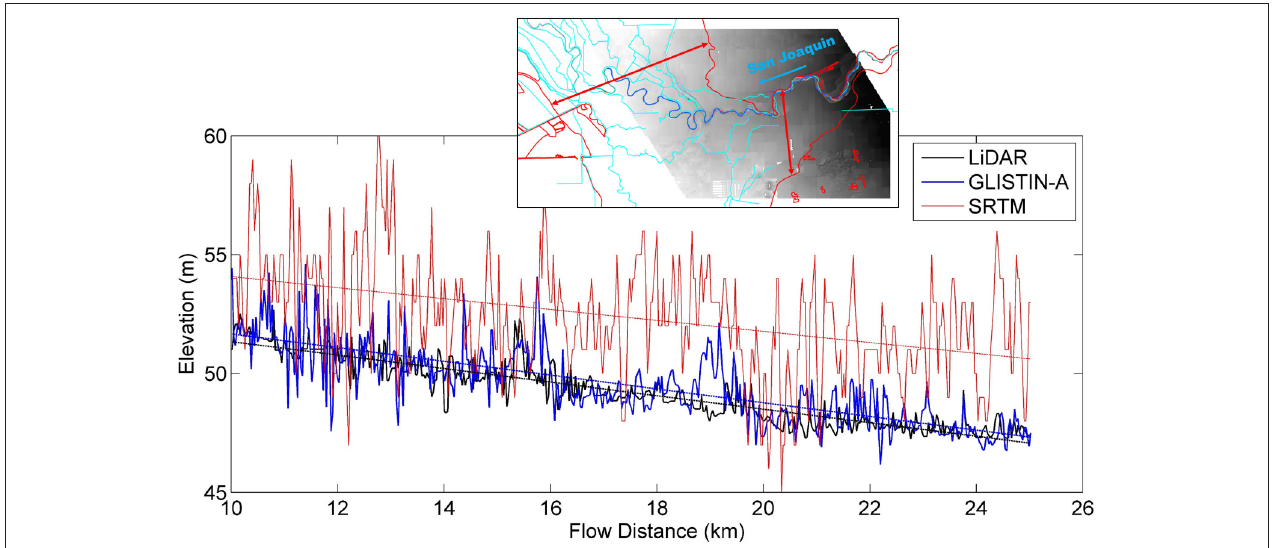
FIGURE 5 | Plot showing the heights along the river centerline in flow direction for the LiDAR, InSAR, and SRTM DEMs. The linear slope is also shown. The inset shows the boundaries of the FEMA 1:100 year flood extent in red and the main river in blue.